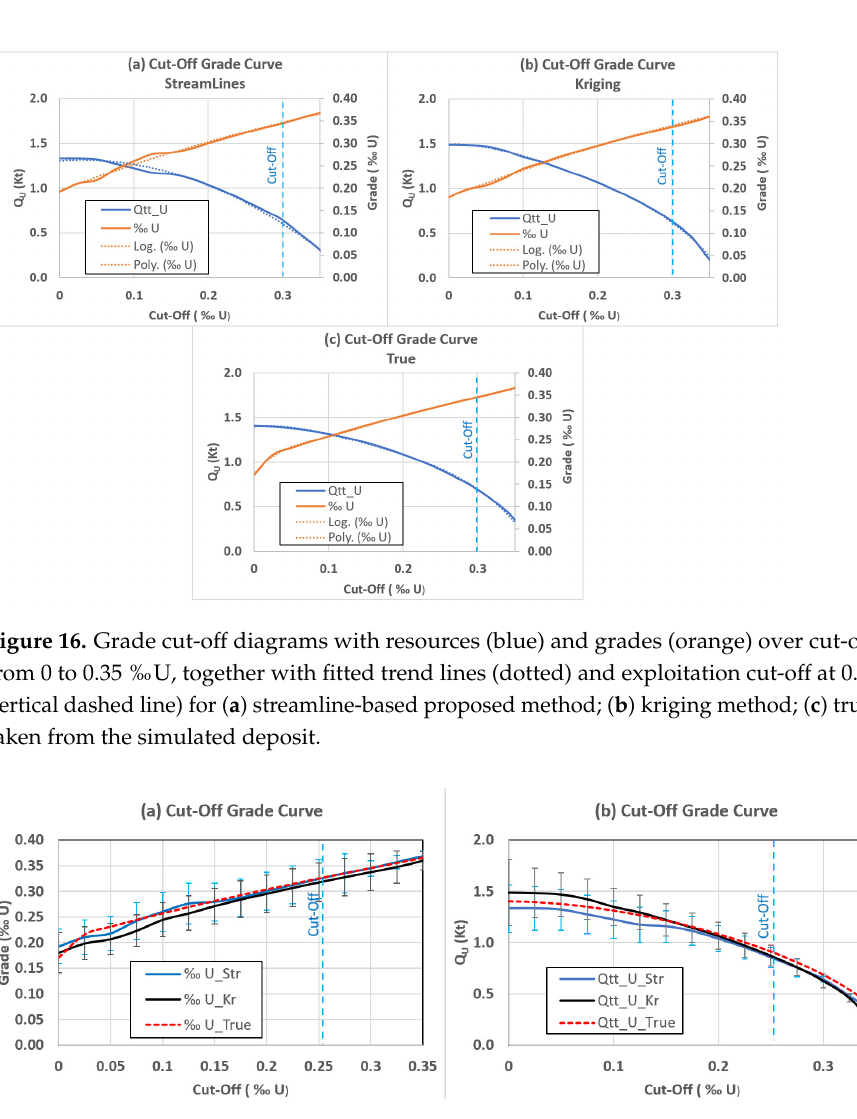
Figure 17. Grade cut-off curves with ( a ) grades and uncertainty; ( b ) quantity of U and uncertainty for streamline-based method (blue) and kriging method (black) and synthetic deposit (red, dashed).